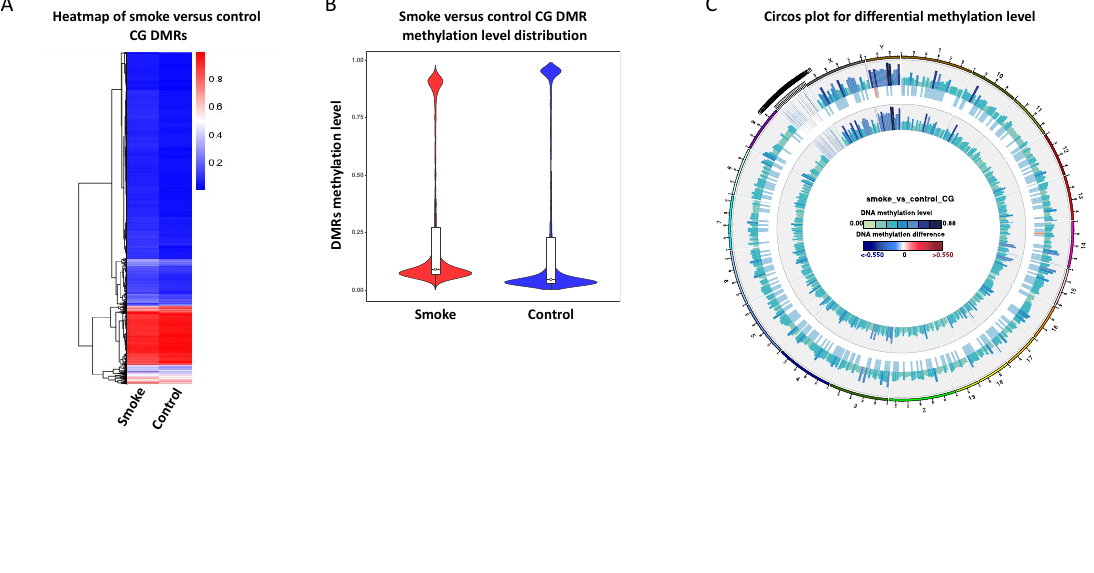
Figure 2. Differential methylation of smoke-exposed versus non-exposed mice. ( A ) Heatmap of DMRs separated by exposure group and representing all 20 animals. ( B ) Violin plot showing average methylation level for DMRs separated by exposure group. ( C ) The Circos plot reflects the difference of the combined methylation levels of the exposure groups. Methylation of the smoke-exposed mice are around the outside and methylation of the non-exposed mice are around the inside. In between is the methylation difference between exposure group with blue denoting that the smoke-exposed mice have a more methylated profile and red denoting a less methylated